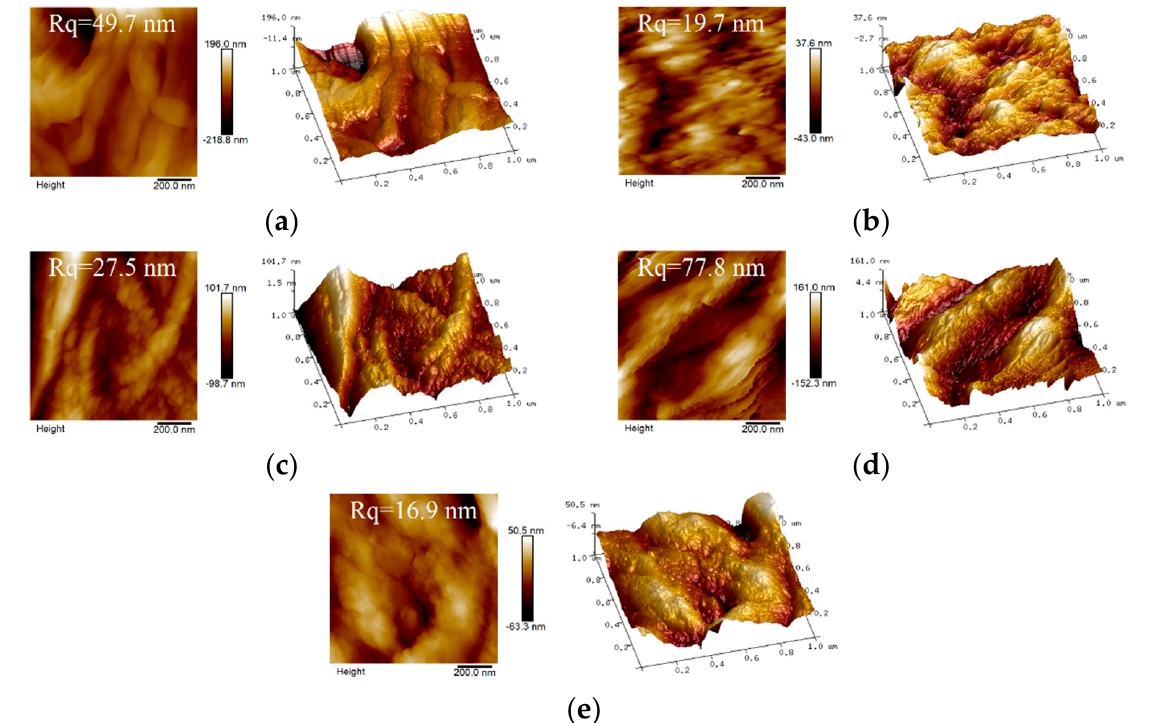
Figure 3. AFM images of ( a ) F ‐ A ‐ T0, ( b ) P ‐ A ‐ T3, ( c ) F ‐ A ‐ T3, ( d ) F ‐ B ‐ T5 ‐ P0, ( e ) F ‐ B ‐ T5 ‐ P1.5 scaffolds.